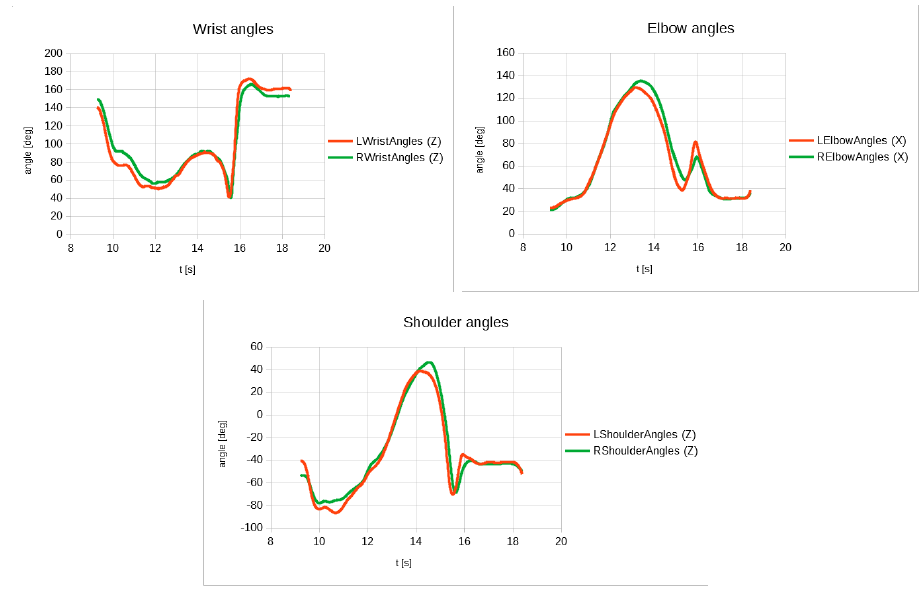
Figure 9. Angles for upper body parts for the first sequence.